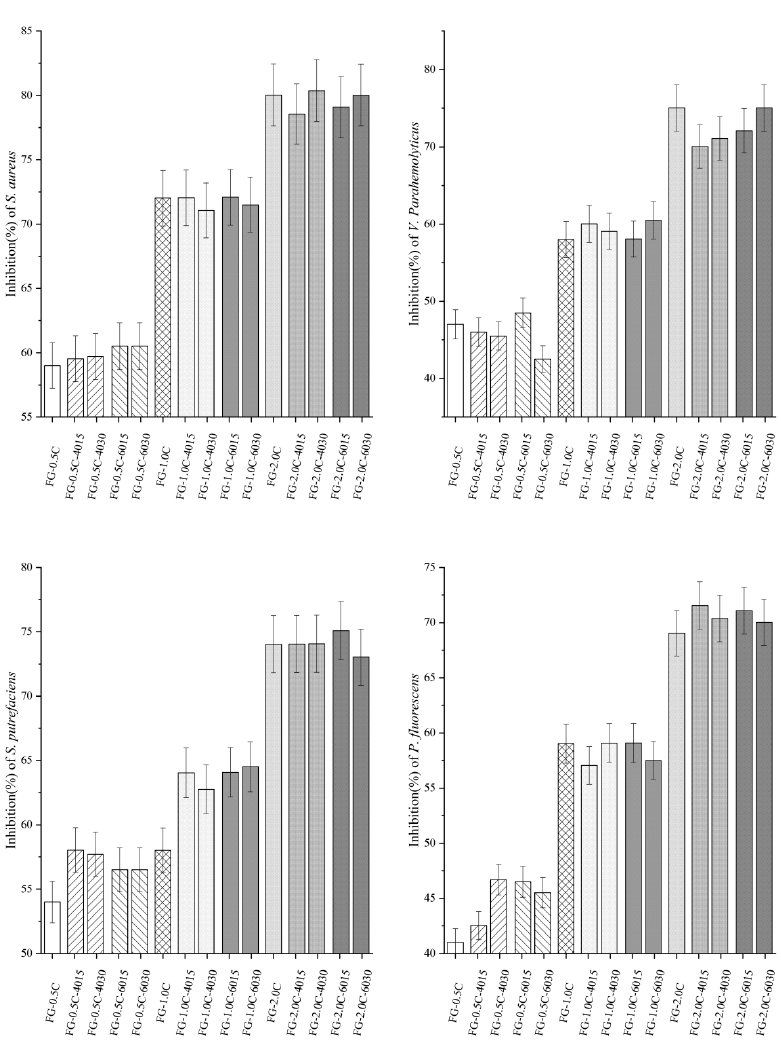
Figure 6. E ff ect of sonicationon antibacterial activities of flaxseed gum films incorporated with carvacrolagainst Staphylococcus aureus , Vibrio parahaemolyticus , Shewanellaputrefaciens , and Pseudomonas fluorescens (The bars with the same pattern had the same carvacrol concentration and sonication power).